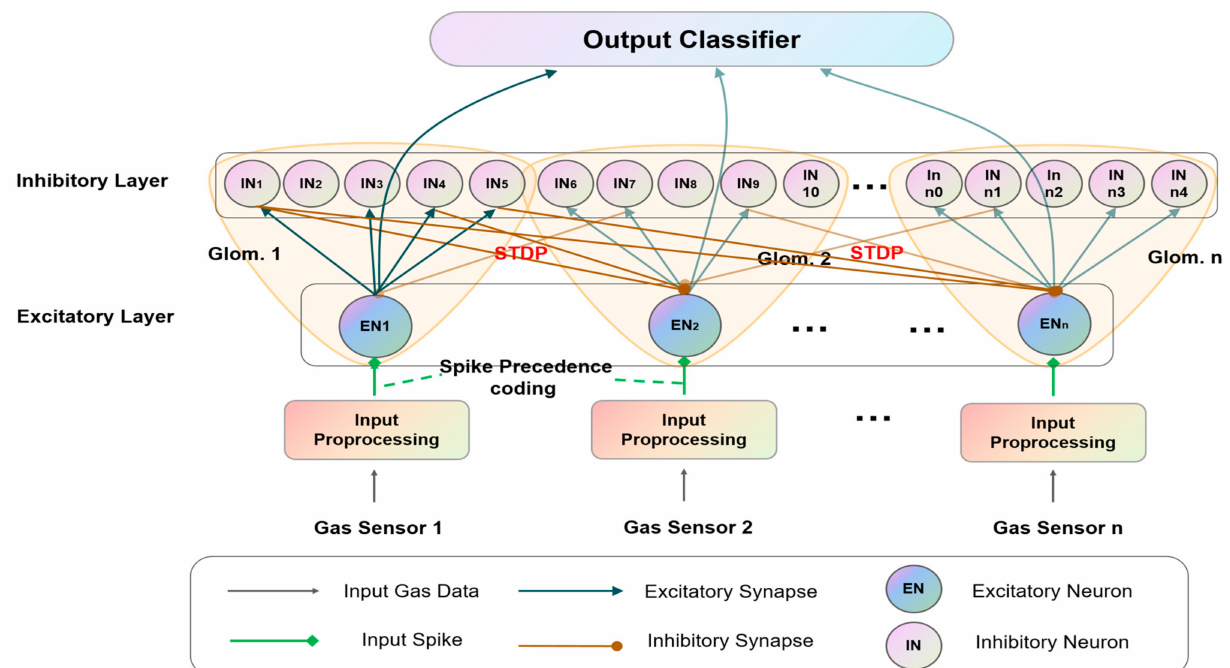
Figure 3. Schematic model of the proposed spiking neural